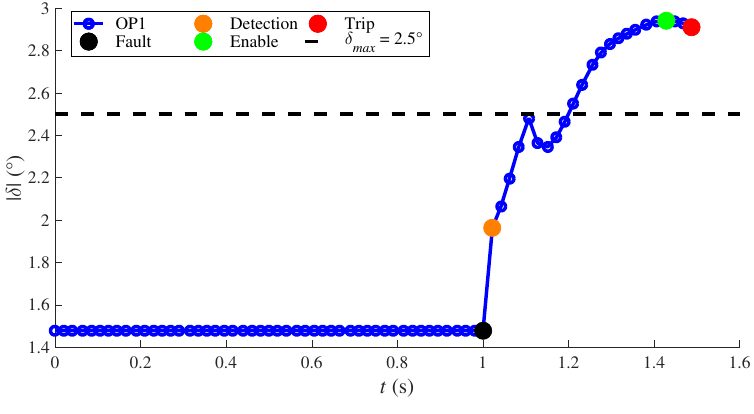
Figure 11. Angle difference scheme operation on